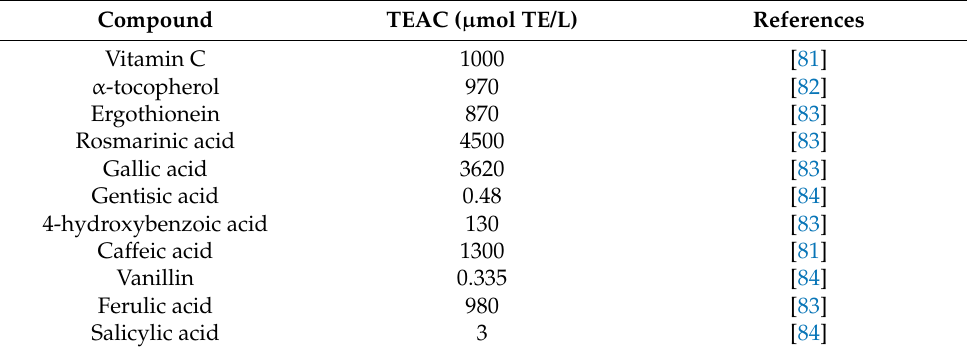
Table 3. Antioxidant capacity of pure